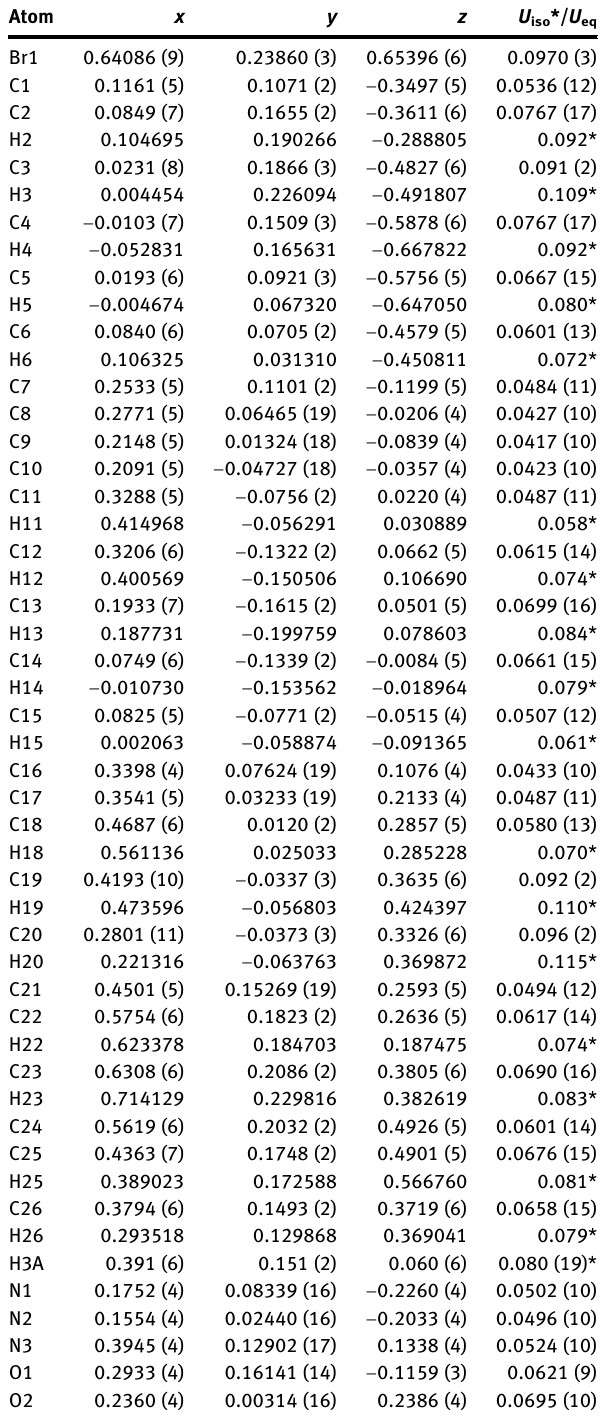
Table  : Fractional atomic coordinates and isotropic or equivalent isotropic displacement parameters (Å 